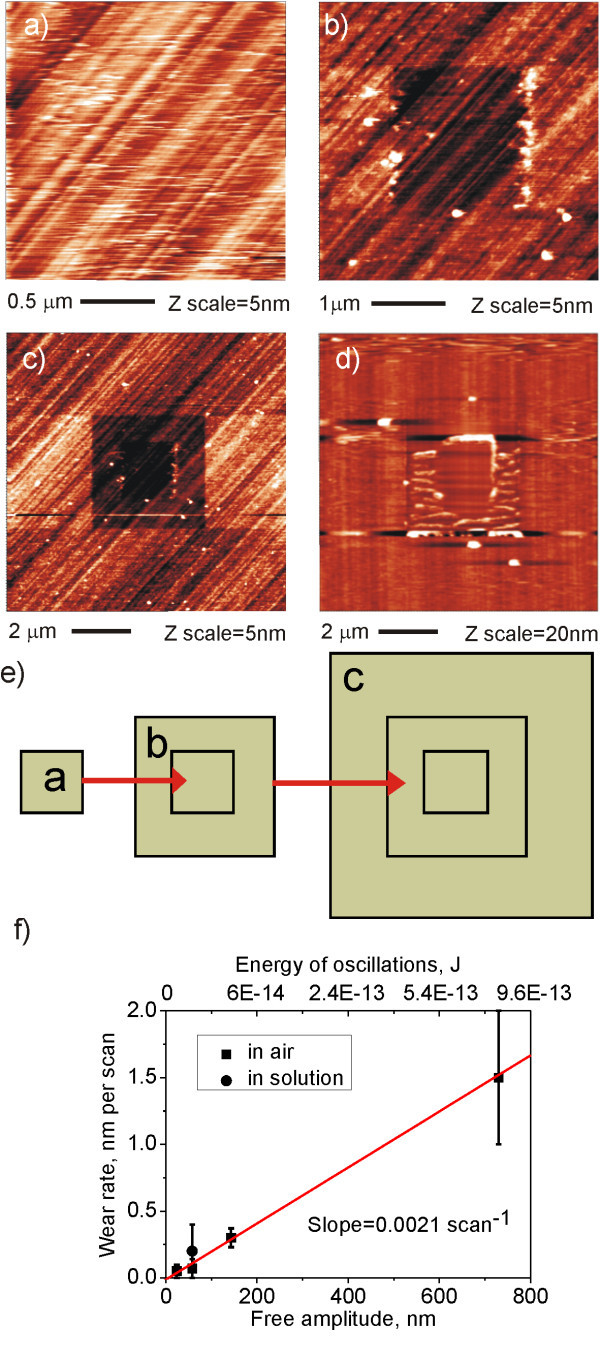
Wear of protein layers in tapping mode AFM. AFM image of FBS layer on monocrystalline diamond (MCD) in McCoy medium using NSG01 tip (NT-MDT): (a) The protein layer was removed from 2 × 2 μm2 area in CM (F ~ 600 nN). (b) The protein layer was partially removed from 4 × 4 μm2 area using 5 scans in TM (A0 ~ 60 nm, E ~ 10-15 J). (c) The protein layer was measured by TM, scan 10 × 10 μm2 (A0 ~ 60 nm). (d) FBS layer on MCD was studied in CM and TM in air using NSG01 tip. FBS layer was removed after just 2 scans with the highest amplitude (A0 ~ 700 nm, E ~ 10-12 J). (e) The scheme illustrates the TM nanoshaving experiment as shown in (a-c). (f) Wear rate dependence on free amplitude and oscillation energy for TM nanoshaving of FBS layer adsorbed on MCD using medium k (NSG01) cantilevers, rSP = 0.5.